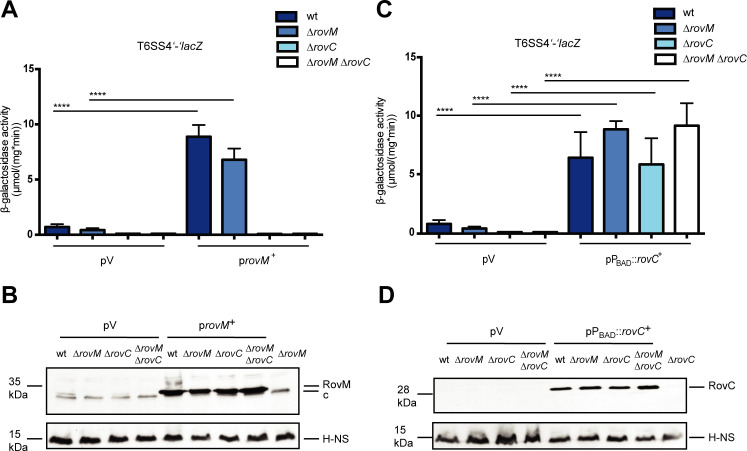
RovM-dependent T6SS4 activation.Expression of a translational T6SS4’-‘lacZ fusion (pSSE64) was analyzed in the Y. pseudotuberculosis wild type strain YPIII, the ΔrovM (YP72), the ΔrovC (YP154) and the ΔrovC/ΔrovM mutant (YP338). The strains were transformed with (A) the empty vector pV (pIV2) or were complemented with the rovM+ overexpression plasmid pAKH64 (provM+) or (C) transformed with the empty vector pZA24 (pV) or complemented with the inducible rovC+ plasmid pVK46 (pPara::rovC+). β-galactosidase activity (μmol/mg.min) was measured after strains were grown over night at 25°C. The data represent the mean ± standard deviation of two independent experiments, carried out in triplicates. Data were analyzed by the Student’s t test; ** P<0.01. RovM (B) or RovC (D) protein amounts were monitored in the wild type strain (YPIII), the ΔrovM (YP72), the ΔrovC (YP154) and the ΔrovCΔrovM mutant (YP338), transformed with (B) the empty vector pIV2 (pV) or the rovM+ overexpression plasmid pAKH64 (provM+) or (D) the empty vector pZA24 (pV) or the rovC+ overexpression plasmid pVK46 (pPara::rovC+). Whole cell extracts were prepared from cultures grown overnight at 25°C, separated on 15% SDS gels and transferred onto a PVDF membrane. Proteins were detected by immunoblotting with a polyclonal RovM (B) or RovC (D) antibody and H-NS protein amounts were used as loading control. The respective mutant strains served as negative controls.